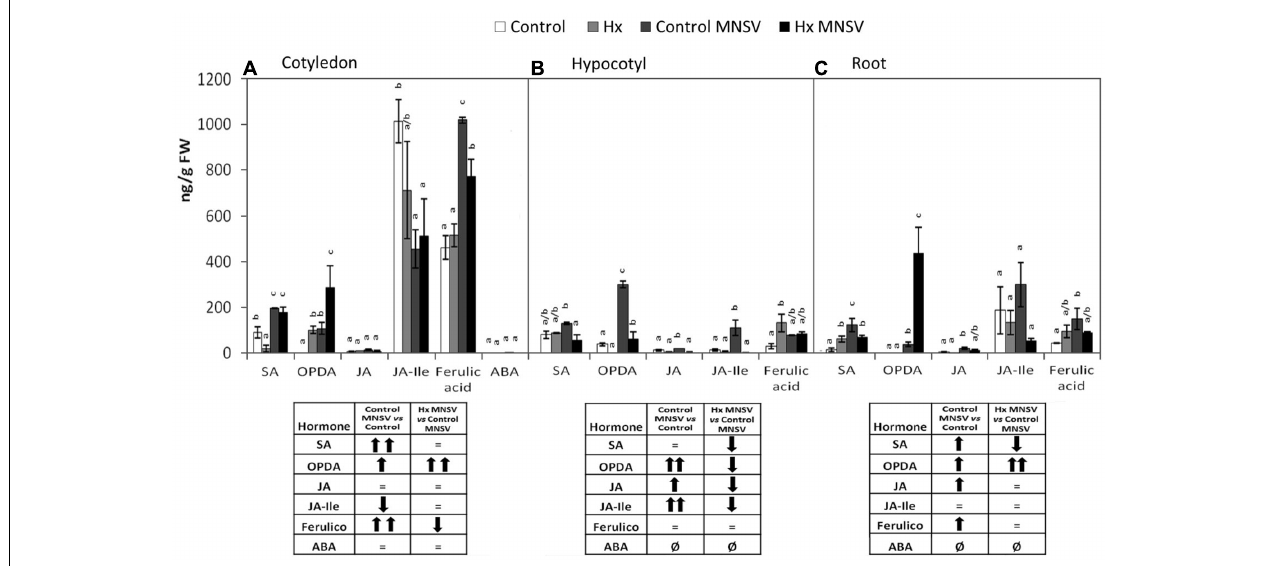
FIGURE 7 | Metabolic profile in the control and Hx-treated plants upon MNSV infection in middle infection stages. Plants were grown and inoculated as described in Figure 2C . Different tissues were collected at 5 dpi, and the SA, OPDA, JA, JA-Ile, ferulic acid, and ABA levels were determined by UPLC–MS. (A) Cotyledon, (B) hypocotyl, and (C) root metabolic profiles. Significant changes are symbolized in a table below the graph: (=) no significant differences; ( ↑ , ↓ ) statistically significant increase or decrease; and ( ↑↑ , ↓↓ ) statistically significant twofold increase or decrease. Data represent the mean ± SE of three independent experiments with 10 plants per experiment. Letters indicate statistically significant differences for each hormone ( p < 0.05; least significant difference